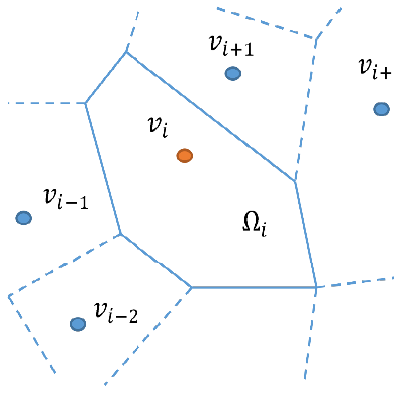
Figure 2. The Voronoi of cell Ω 𝑖 in 𝑅 2 .